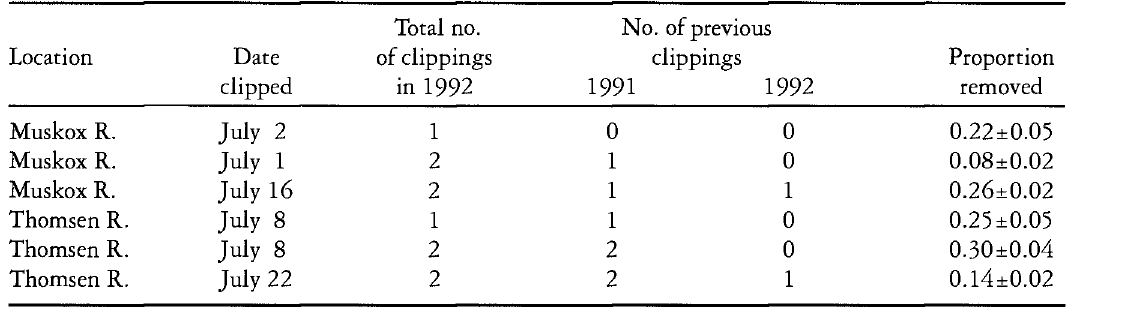
Table 3. Standing crop estimates (g/m 2 ) (mean+SE) (»=5 per treatment) obtained in 1992 and 1993 for plots with vari able clipping histories inside permanent exclosures in 1992 and 1993, northern Banks Island, Canada.